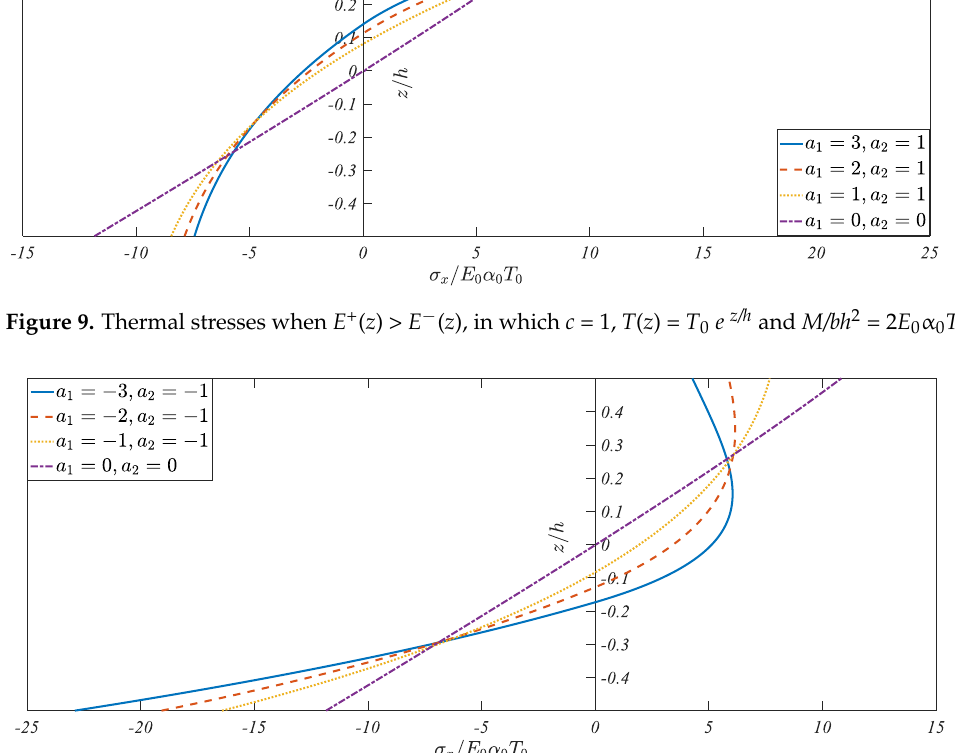
Figure 10. Thermal stresses when E + ( z ) < E − ( z ), in which c = 1, T ( z ) = T 0 e z/h and M/bh 2 = 2 E 0 α 0 T 0 . From Figures 9 and 10, it is easy to see that: